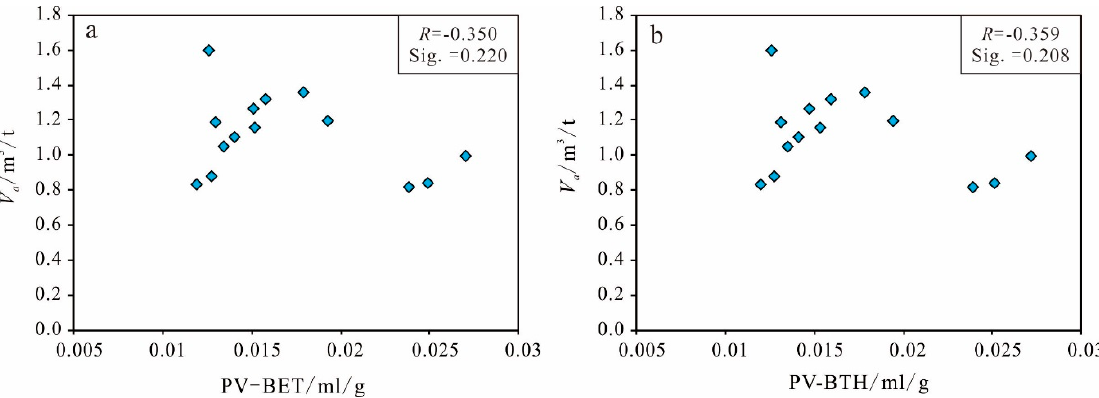
Figure 18. Influence of total pore volume on AGC in shales. (a) Correlation between Va and PV based on BET model; (b) correlation between Va and PV based on BTH model.